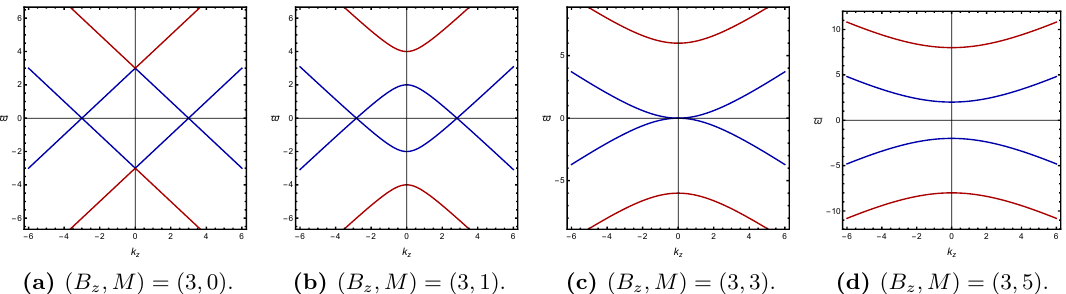
Figure 1. (a)-(d): the band structure depends on B z =M . The (cid:12)gure is in ( k z ; (cid:22) ! )-space at k x = 0 ; k y = 0 slice. Here (cid:22) ! = ! + q(cid:22) .